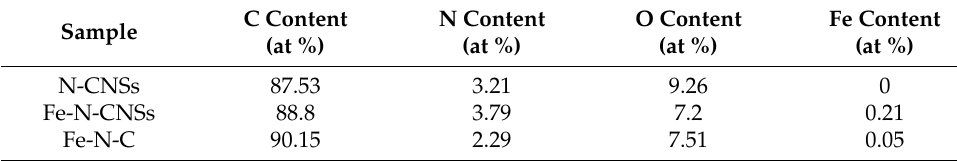
Table 1. Elemental composition of the catalysts measured by XPS.